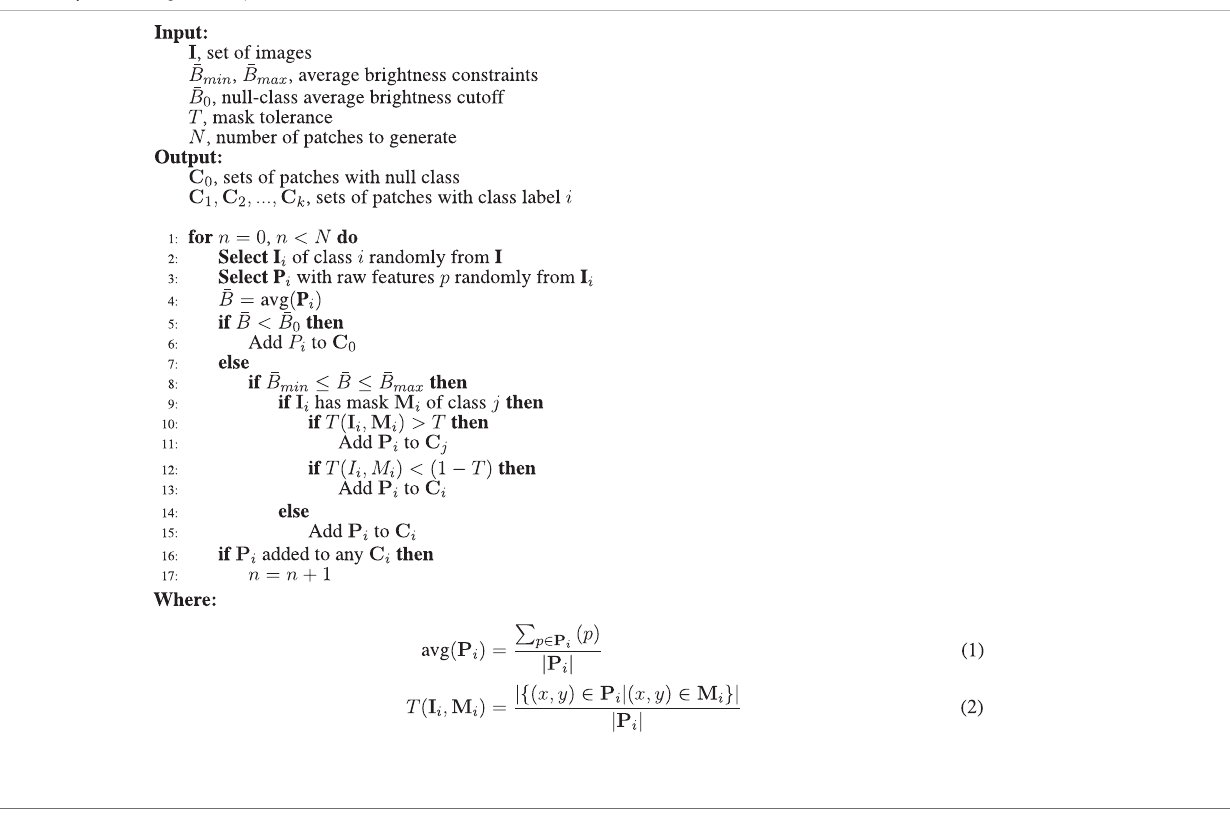
Algorithm 1 | Patch categorization